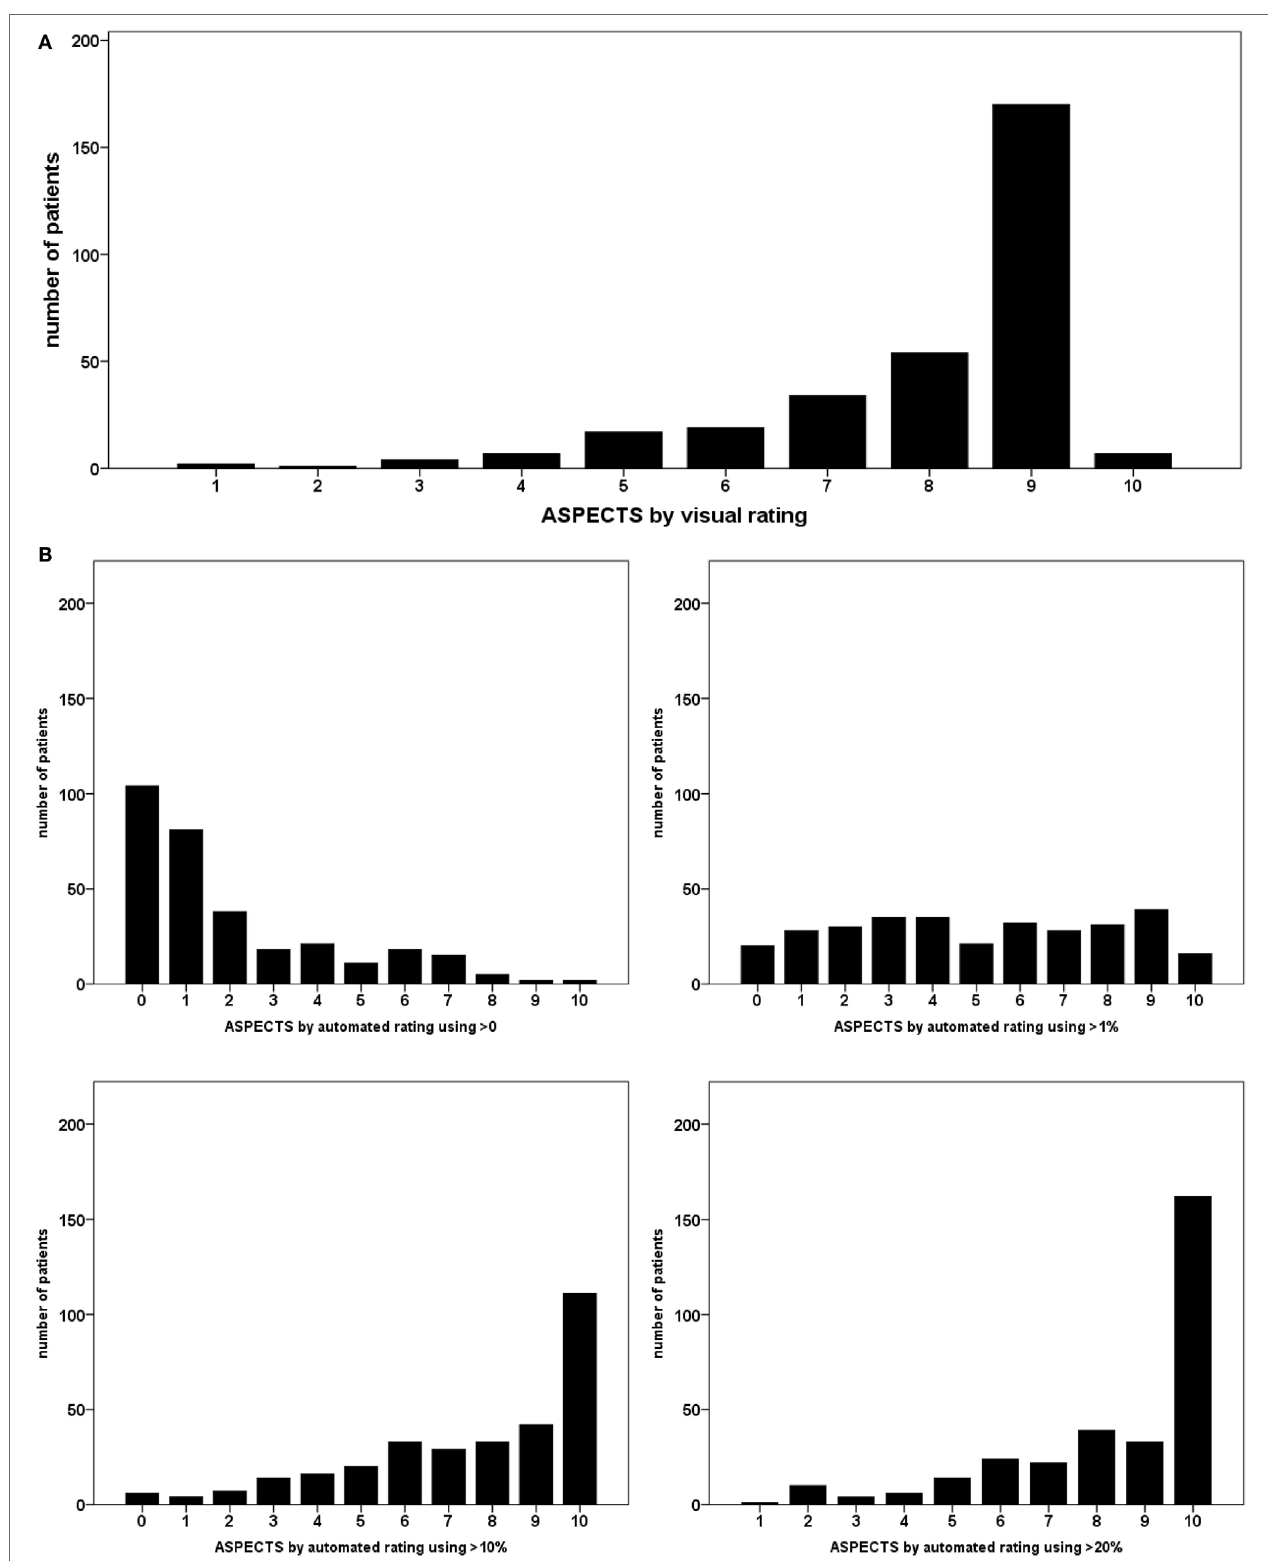
FigUre 3 | Distribution of Alberta Stroke Program Early Computed Tomography scores over the different relative lesion load (RLL) thresholds in automated rating; each bar represents the number of patients allotted the respective overall score; (a) visual rating; (B) automated rating using RLL